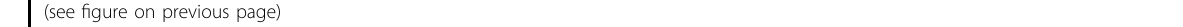
Fig. 2 LINC00263 is a novel target of hnRNPK. a , b To identify hnRNPK-regulated lincRNAs, RNA sequencing was performed using total RNAs isolated from hnRNPK- and LINC00263 -silenced HeLa cells. a Volcano plots were generated by analyzing the sequencing data. b Information about the fi ve hnRNPK-regulated lincRNAs is summarized. c , d RNA sequencing results were veri fi ed by assessing the level of LINC00263 in hnRNPK-silenced cells. Knockdown of hnRNPK by two independent siRNAs was veri fi ed by Western blot analysis ( c ) and the levels of HNRNPK mRNA and LINC00263 were determined by RT-qPCR analysis ( d ). To check whether knockdown of LINC00263 affects hnRNPK expression, the levels of hnRNPK protein ( e ) and HNRNPK mRNA ( f ) were determined by Western blot and RT-qPCR analyses, respectively. g , h To con fi rm that hnRNPK regulates LINC00263 , a speci fi c siRNA targeting the 3 ′ UTR of HNRNPK mRNA was used. HeLa cells were cotransfected with the 3 ′ UTR-speci fi c HNRNPK siRNAs and Flag- hnRNPK vector. The level of endogenous and ectopic hnRNPK (Flag-hnRNPK) was determined by Western blot analysis. GAPDH was used as a loading control ( g ). The level of LINC00263 in transfected cells as described above was determined by RT-qPCR analysis ( h ). i Direct association of hnRNPK with LINC00263 was tested by RNP-IP experiment using control IgG and hnRNPK antibody. The enrichment of LINC00263 was calculated by comparing the level of LINC00263 in IgG and hnRNPK IP materials. The level of LINC00263 was determined by RT-qPCR analysis and 18S was used for normalization. j Following transfection of HeLa cells with wild-type (full length, FL) or four deletion mutant vectors, RNP-IP was performed using an anti-Flag antibody. The level of LINC00263 in the Flag IP was quanti fi ed by RT-qPCR analysis. The Schematic represents wild-type and four mutants of hnRNPK ( Δ KH1, Δ KH1/2, Δ KH2, and Δ KH3) used in this study. k The effect of hnRNPK on the stability of LINC00263 was examined. Following treatment of actinomycin D (0.5 μ g/ml), cells were harvested at the indicated times and the levels of LINC00263 and GAPDH mRNA were determined by RT-qPCR analysis. Statistical analyses were performed using the Student ’ s t -test using three independent experiments (* p < 0.05). All data represent mean ± standard variation